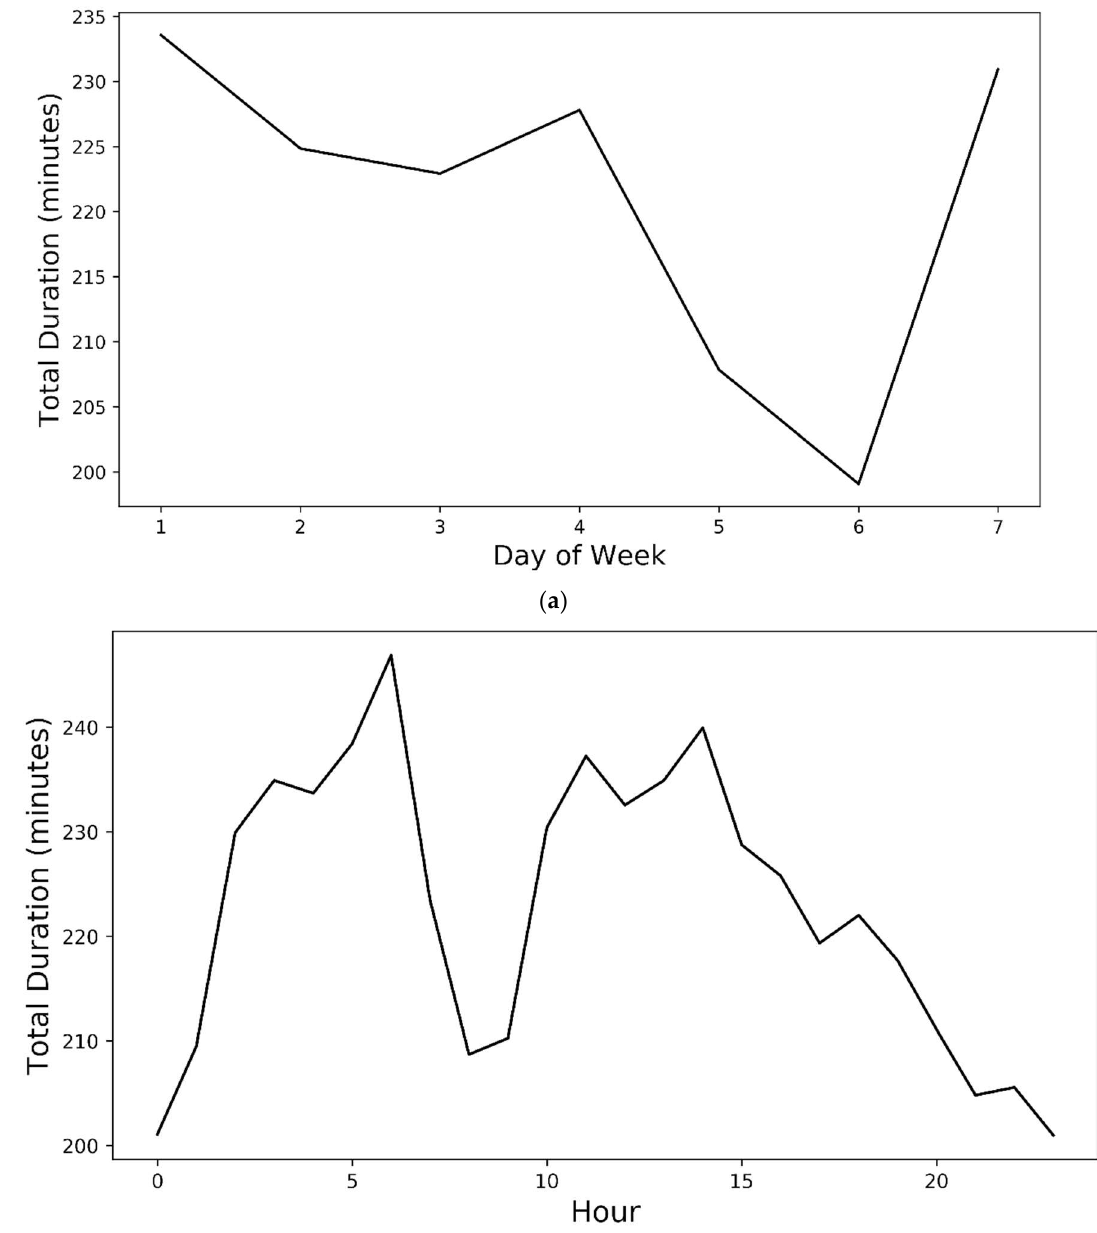
Figure 7. ( a ) Total duration grouped by hour. ( b ) Duration of patient drive by day of the week. The number 1 represents Monday and 7 represents Sunday.